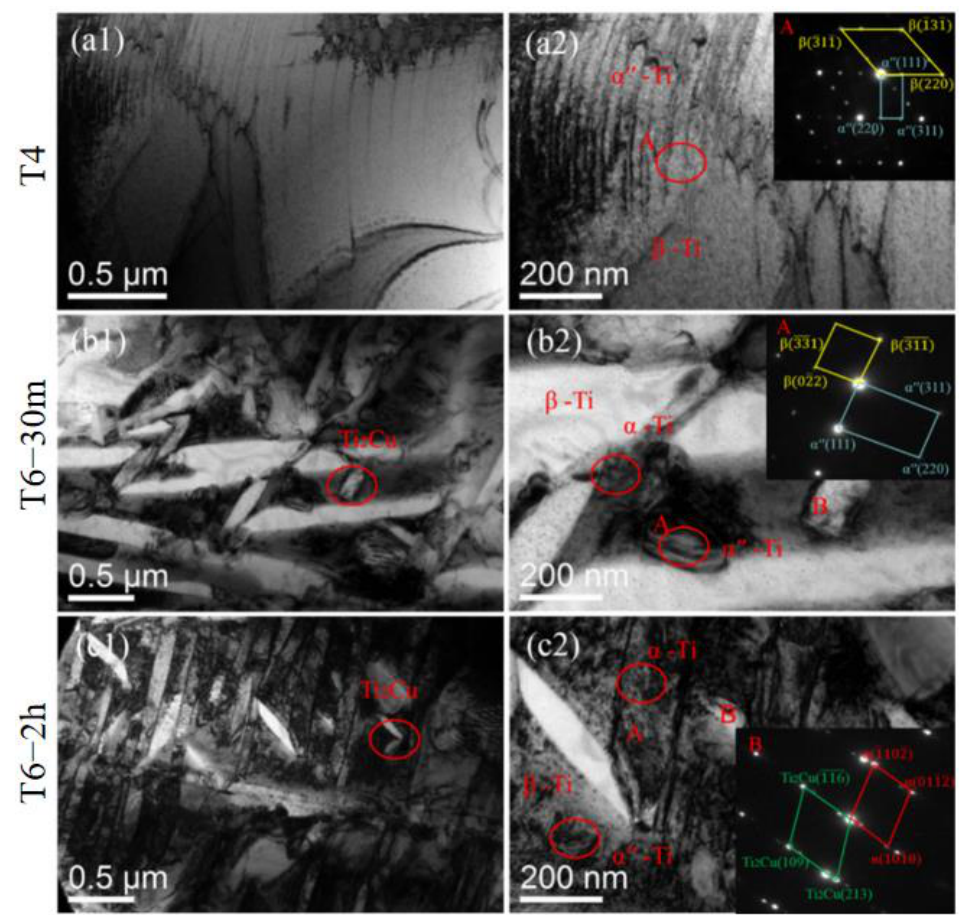
Figure 5. TEM images of TNZ-3Cu samples. ( a1,a2 ) TNZ-3Cu(T4); ( b1,b2 ) TNZ-3Cu(T6-30m); ( c1,c2 ) TNZ-3Cu (T6-2h).